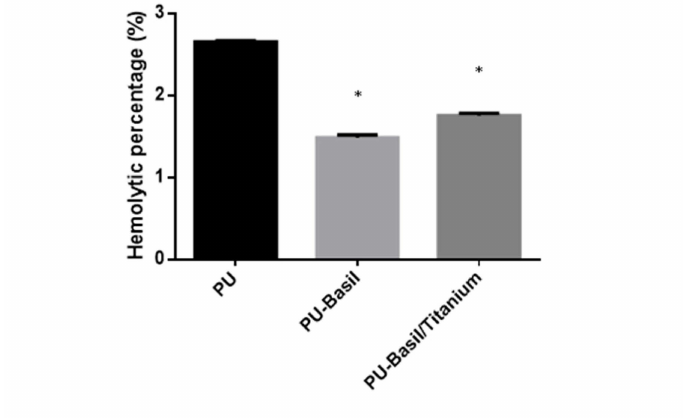
Figure 12. PT assay PU, PU / BASIL and PU / BASIL / TiO 2 .